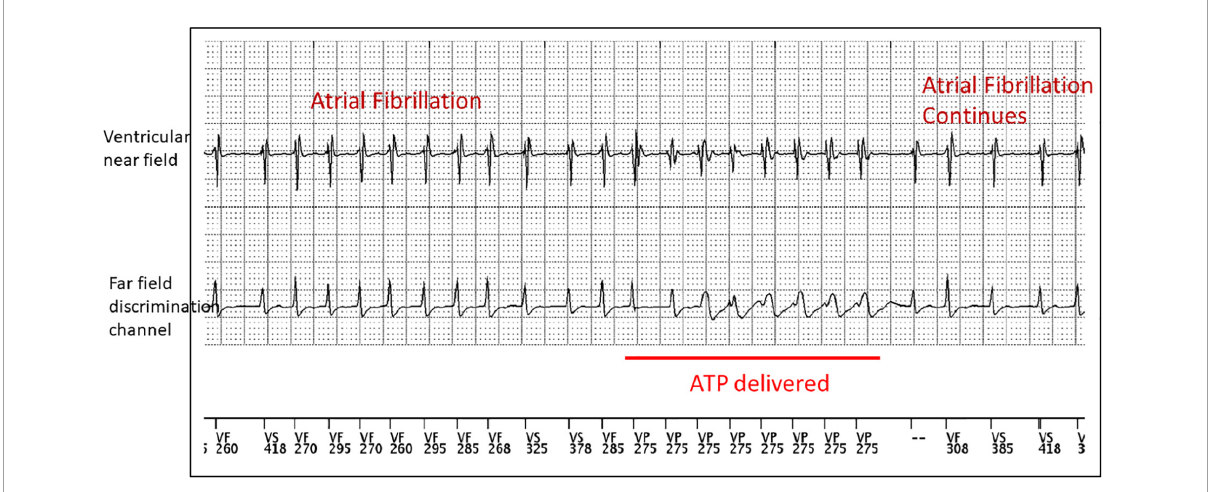
FIGURE3 Device tracings of a 50 year old male with non-ischemic heart disease who experienced episodes of atrial fibrillation with rapid AV conduction into his ventricular fibrillation zone that resulted in the delivery of anti-tachycardia pacing. This event occurred while taking amyl nitrite during sexual activity. ATP, anti-tachycardia